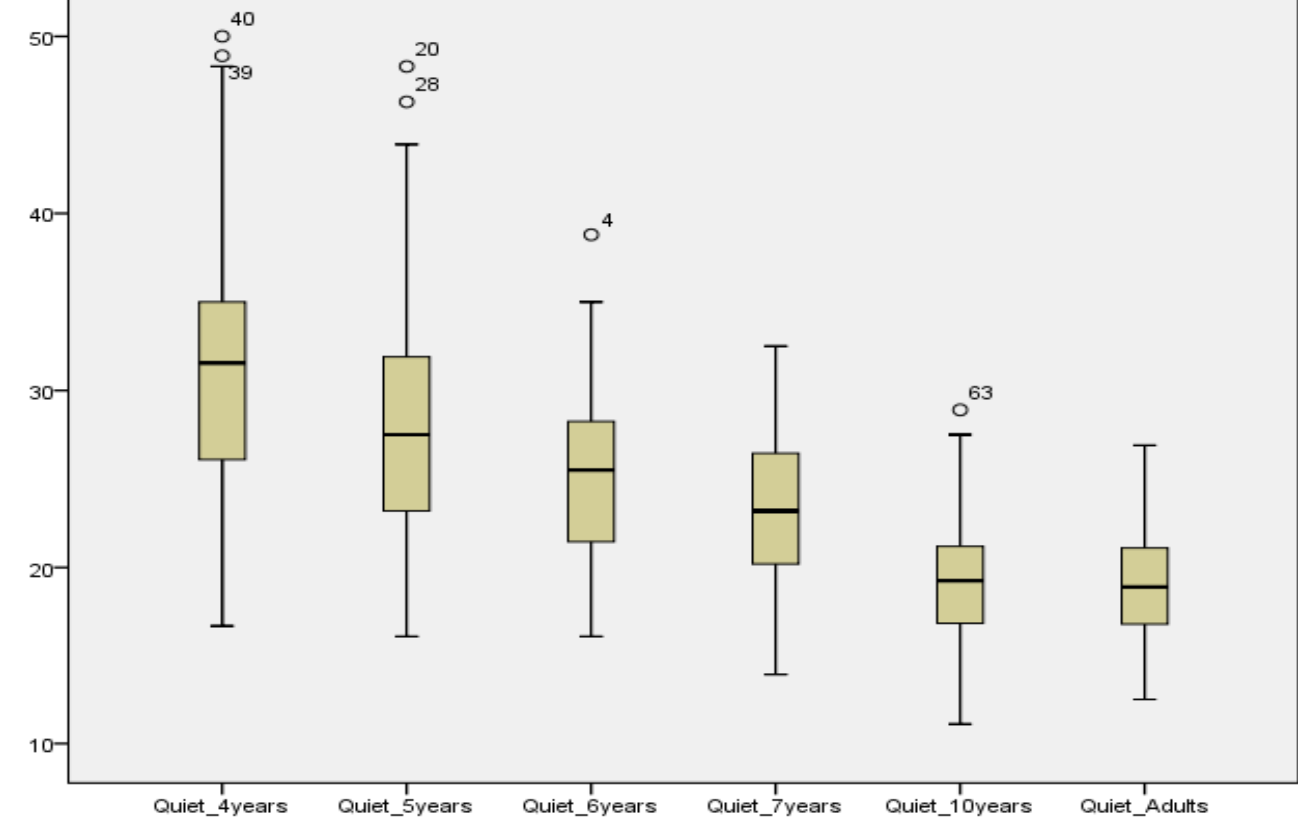
Figure 7. Comparison of mean SRT values in quiet across age groups.